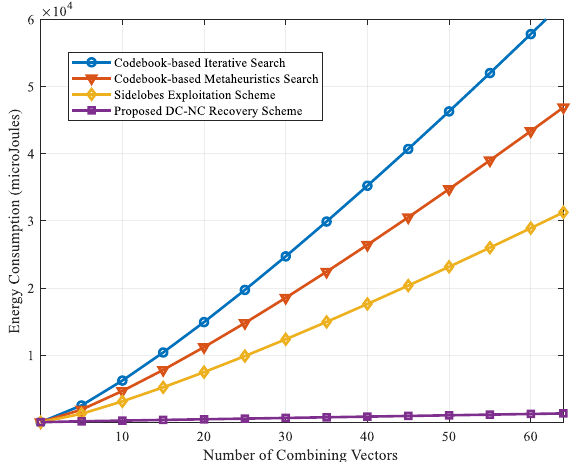
Figure 5. Energy consumption observed at different numbers of combining vectors.